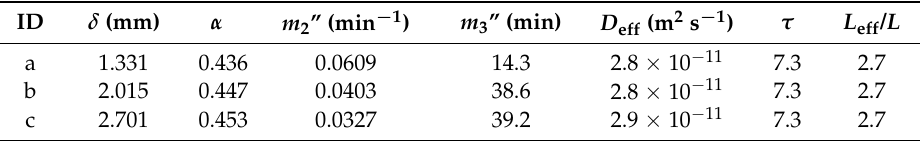
Table 3. Effective diffusion coefficient D eff and tortuosity factor τ of samples and related parameters 1 of methylene blue elution.